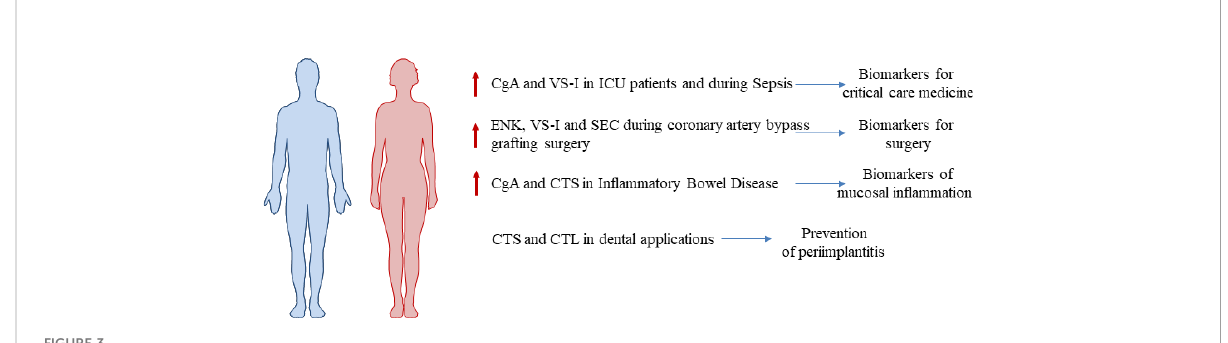
FIGURE 3 AMPs released from the adrenal medulla as biomarkers of human